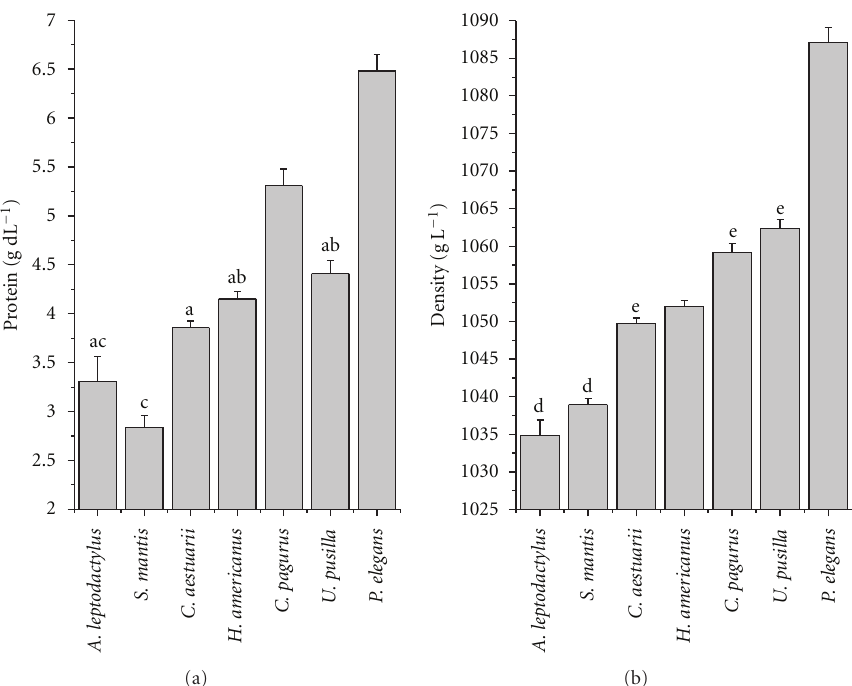
Figure 1: Means and standard error of total protein concentration (a) and hemolymph density (b) in the seven species of crustaceans